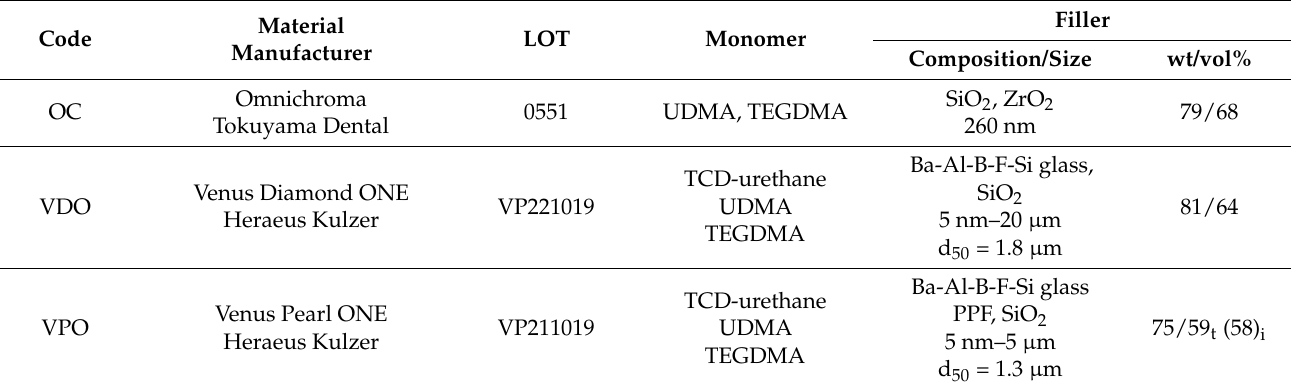
Table 1. Analyzed universal chromatic RBCs, abbreviation code, brand, LOT, and composition, as indicated by the manufacturer.